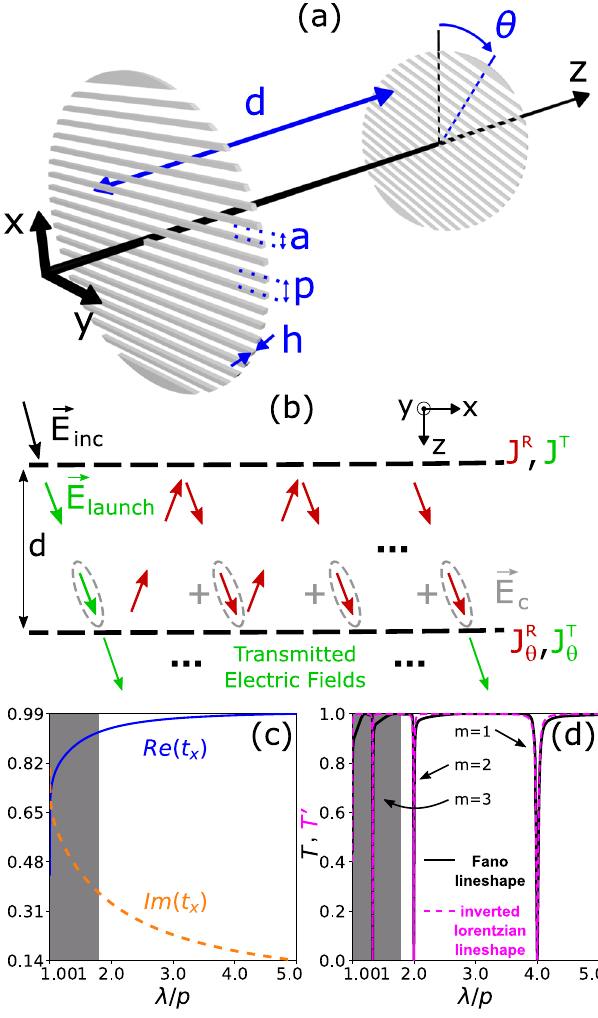
Fig. 1 Structure description and principle. a 3D illustration of two Metallic Wire-Grid Metasurfaces (MWGMs) stacked along the z -axis, separated by a distance d , where the second MWGM is rotated by an angle θ . The thickness, the aperture width and the period are denoted by h , a , and p , respectively. b Principle of the Fabry – Perot-like (FP-like) cavity formed by two MWGMs characterized by their Jones matrices J T , J R and J T θ , J R θ ! ! respectively. E is the initial electric fi eld entering the cavity, and E is launch c the steady state forward circulating fi eld in the FP-like cavity. The arrows are deliberately tilted to clearly represent the round trips in the FP-like cavity. c Simulated spectra of t x , the transmission coef fi cient along the x - axis for one MWGM where λ / p is the normalized wavelength. The real and imaginary parts of t x are depicted in solid blue line and dashed orange line respectively, and computed with a / p = 0.9 and h / p = 0.1. The grayed area speci fi es the spectral region ( λ / p ≤ 1.8) for which the model has lower accuracy. d Simulated transmission spectra of the FP-like cavity with θ = 10° and d / p = 2.0. The integer m denotes the FP harmonic order where the Fano resonances occurs. The black curve shows the spectrum of the transmission T computed with the numerical values extracted from the monomode modal method. The dashed pink curve gives the spectrum of the transmission T 0 computed with the special case where t x =